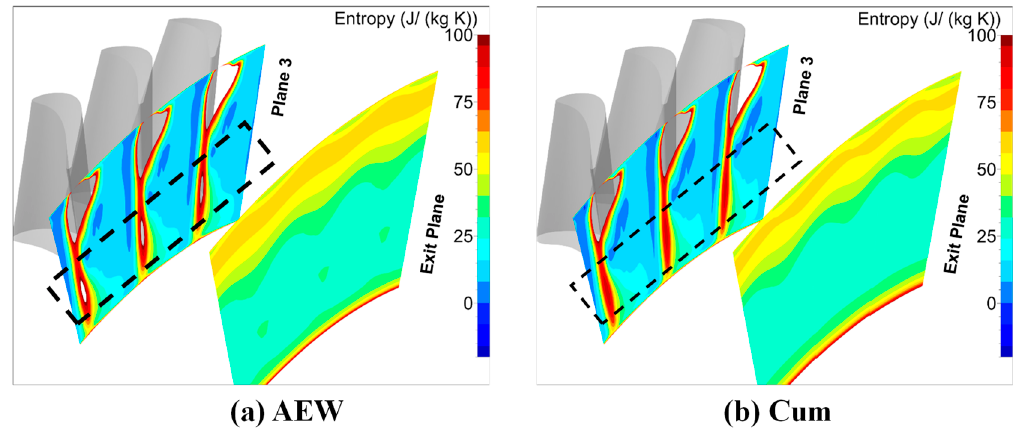
Figure 21. ( a , b ) Time-averaged result of entropy contours at two planes downstream of the rotor.